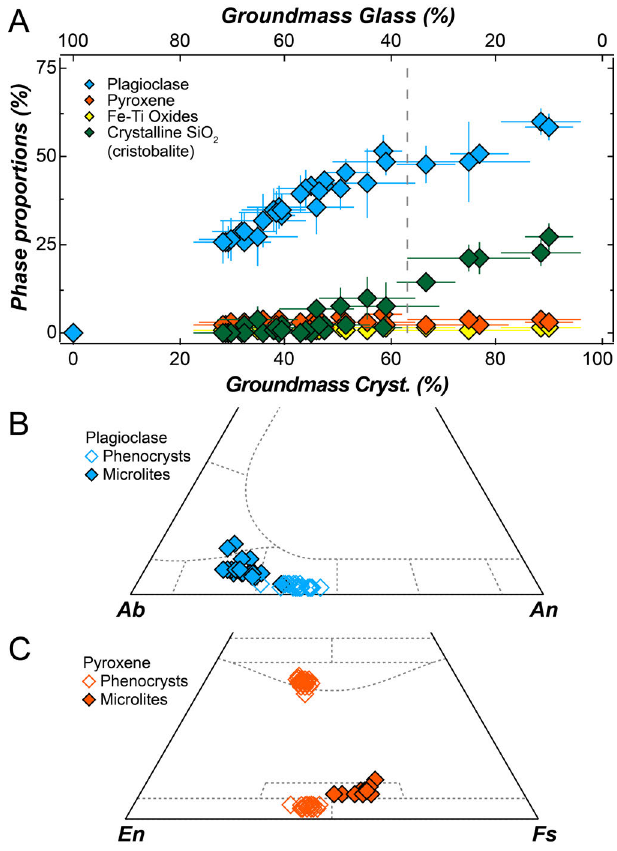
Figure 5: [A] Microlite abundances in each sample as a function of increasing total groundmass crystallinity (equivalent to declining groundmass glass). Crystalline SiO becomes an important groundmass phase above 2 ∼ 63 % total crystallinity (vertical dashed line). Error bars are ± 1 standard deviation to proportions in multi- ple BSE images from each sample. [B–C] Compositions of plagioclase and